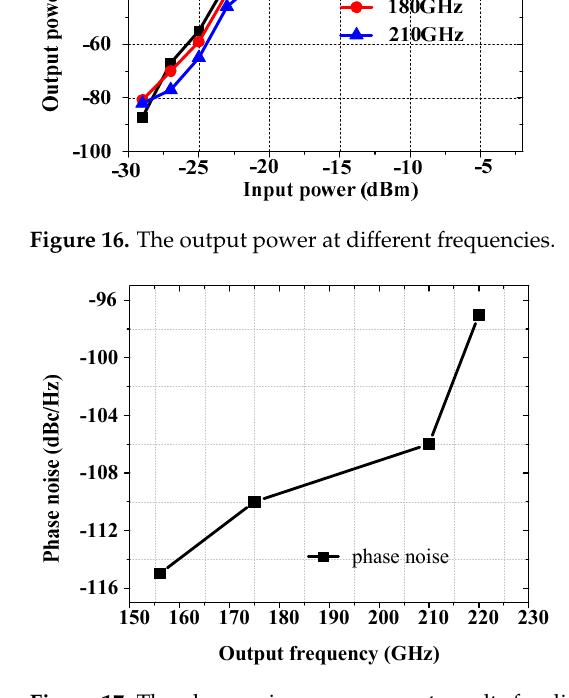
Figure 17. The phase noise measurement results for different frequencies.